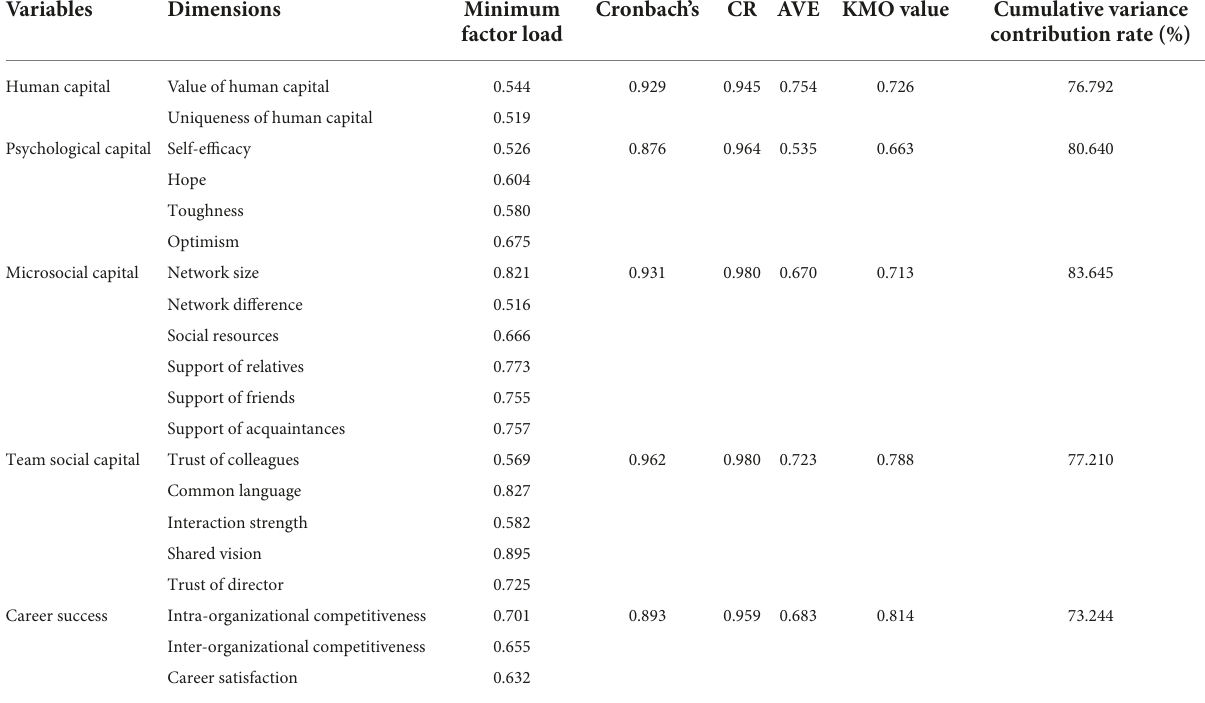
TABLE 2 Reliability and validity